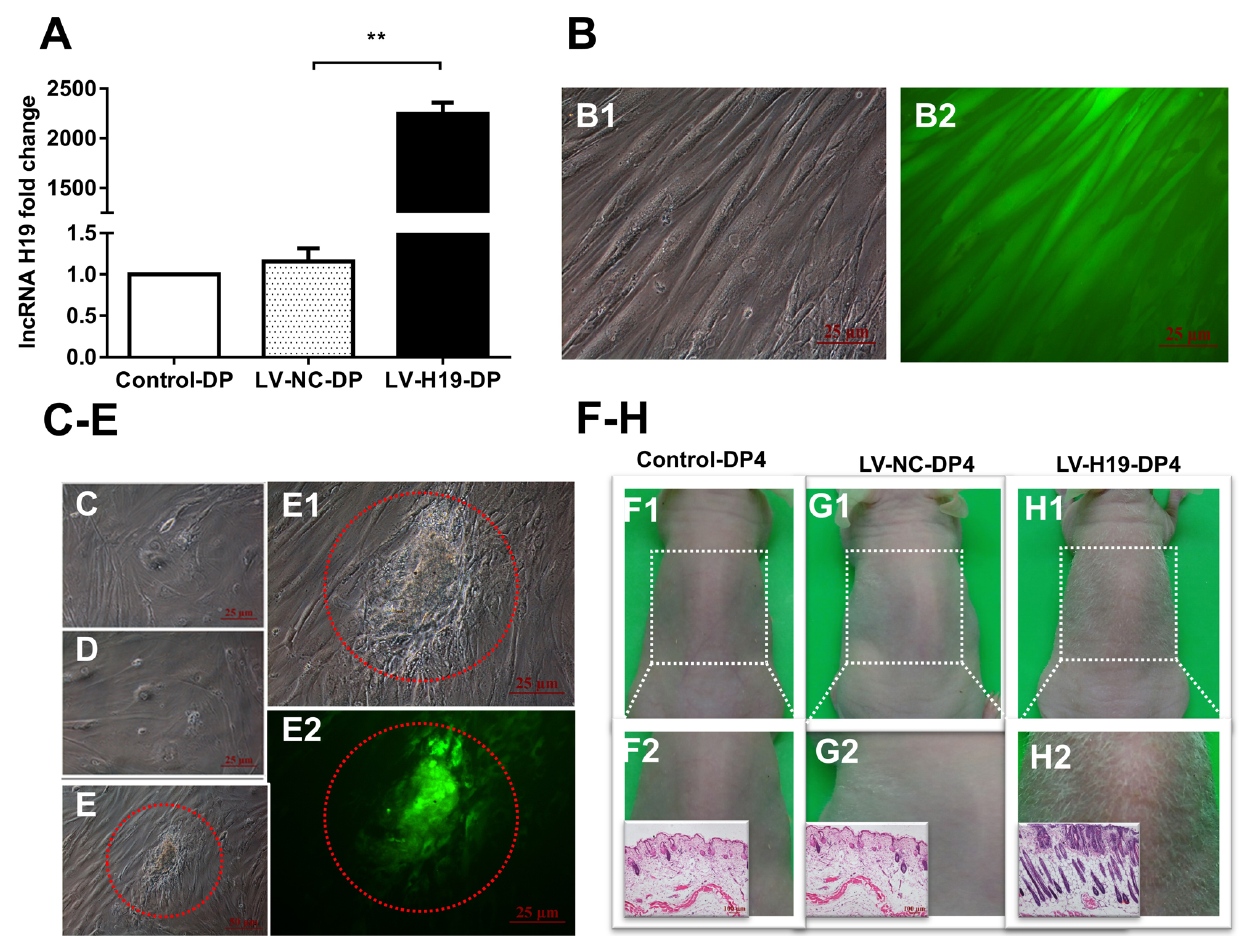
FIGURE 3 | Effects of lncRNAH19 overexpression on maintenance of DP cell viability in vitro and HF-inducing ability in vivo . (A) H19 lentivirus upregulated the level of H19. (B) GFP fluorescent signal showed high infection efficiency (left: bright field; right: fluorescence, scale bar, 25 µ m). (C–E) After infection of DP3 cells with LV-H19 and continuous culture, LV-H19-DP6 cells maintained aggravative behavior (e, red circle), but Control-DP6 or LV-NC-DP6 cells did not (C,D) . (F–H) LV-H19-DP4 cells induced hair generation on NU/NU mice backs after 10 days, with histological examination revealing HF structures, while the other two groups showed no hair growth. Data shown represent the mean ± SEM of three independent experiments. n = 8 mice per group. ** P < 0.01. Control-DP4, normal DP4 cell-injected group, LV-NC-DP4, control virus-infected DP4 cell-injected group, LV-H19-DP4, the H19 overexpression lentivirus-infected DP4 cell-injected group.